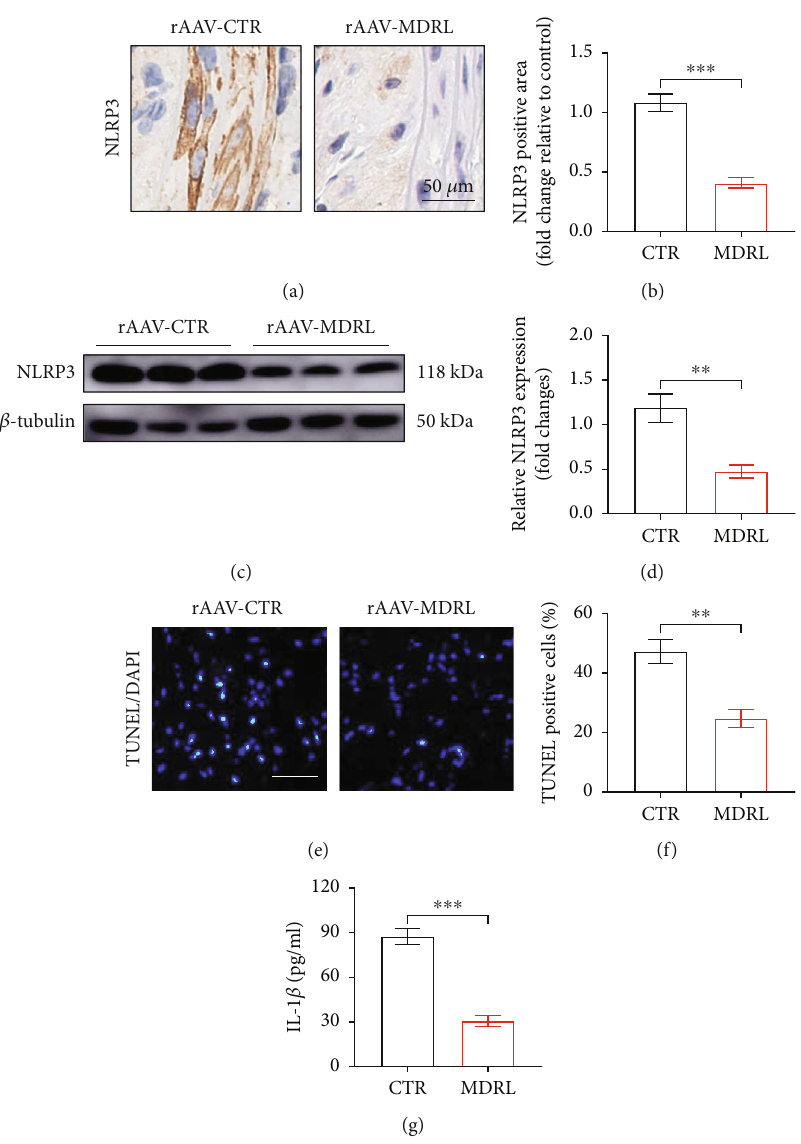
Figure 3: MDRL attenuates NLRP3 in fl ammasome and apoptosis in plaques of LDLR -/- mice fed with HFD. (a) Representative images of IHC staining for NLRP3 in aortic roots from rAAV-CTR- or rAAV-MDRL-treated LDLR -/- mice. Scale bar: 50 μ m. (b) Quanti fi cation of NLRP3 positive area in aortic roots. (c and d) Western blots showed the expression levels of NLRP3 protein in aortas from rAAV-CTR- or rAAV-MDRL-treated LDLR -/- mice. (e) Representative images of TUNEL staining (stained with green) in aortic roots from rAAV- CTR- or rAAV-MDRL-treated LDLR -/- mice. Scale bar: 50 μ m. (f) Quanti fi cation of TUNEL-positive cells in aortic roots. (g). Serum concentration of IL-1 β from rAAV-CTR- or rAAV-MDRL-treated LDLR -/- mice. Data are presented as mean ± SEM. ∗∗ P < 0 : 01 , ∗∗∗ P < 0 : 001 vs rAAV-CTR